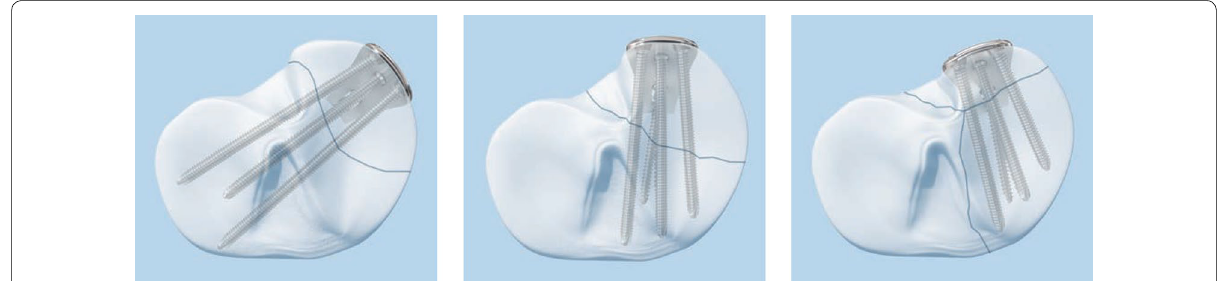
Fig. 3 Potential medial plateau plate positions (3.5-mm LCP posteromedial proximal tibia plate, Synthes technique